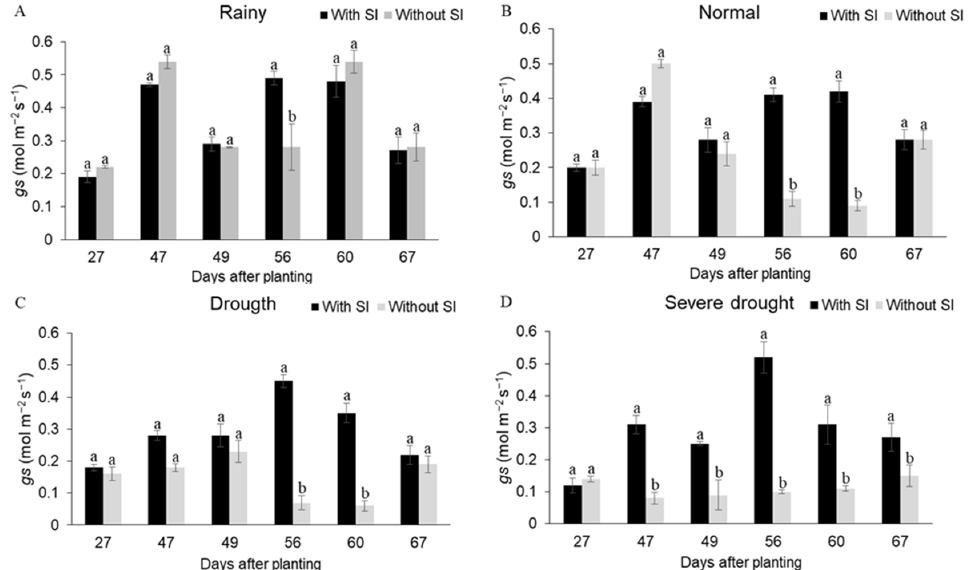
Figure 5. Stomatal conductance of maize leaves under Rainy ( A ), Normal ( B ), Drought ( C ) and Severe drought ( D ) scenarios, showing sampling date and presence or absence of supplemental irrigation (SI) with brackish water (ECw = 4.5 dS m − 1 ). For each sampling date, means followed by the same letters do not differ ( p ≥ 0.05) from each other according to the Tukey test. Error bars represent the standard error of the mean ( n = 4).